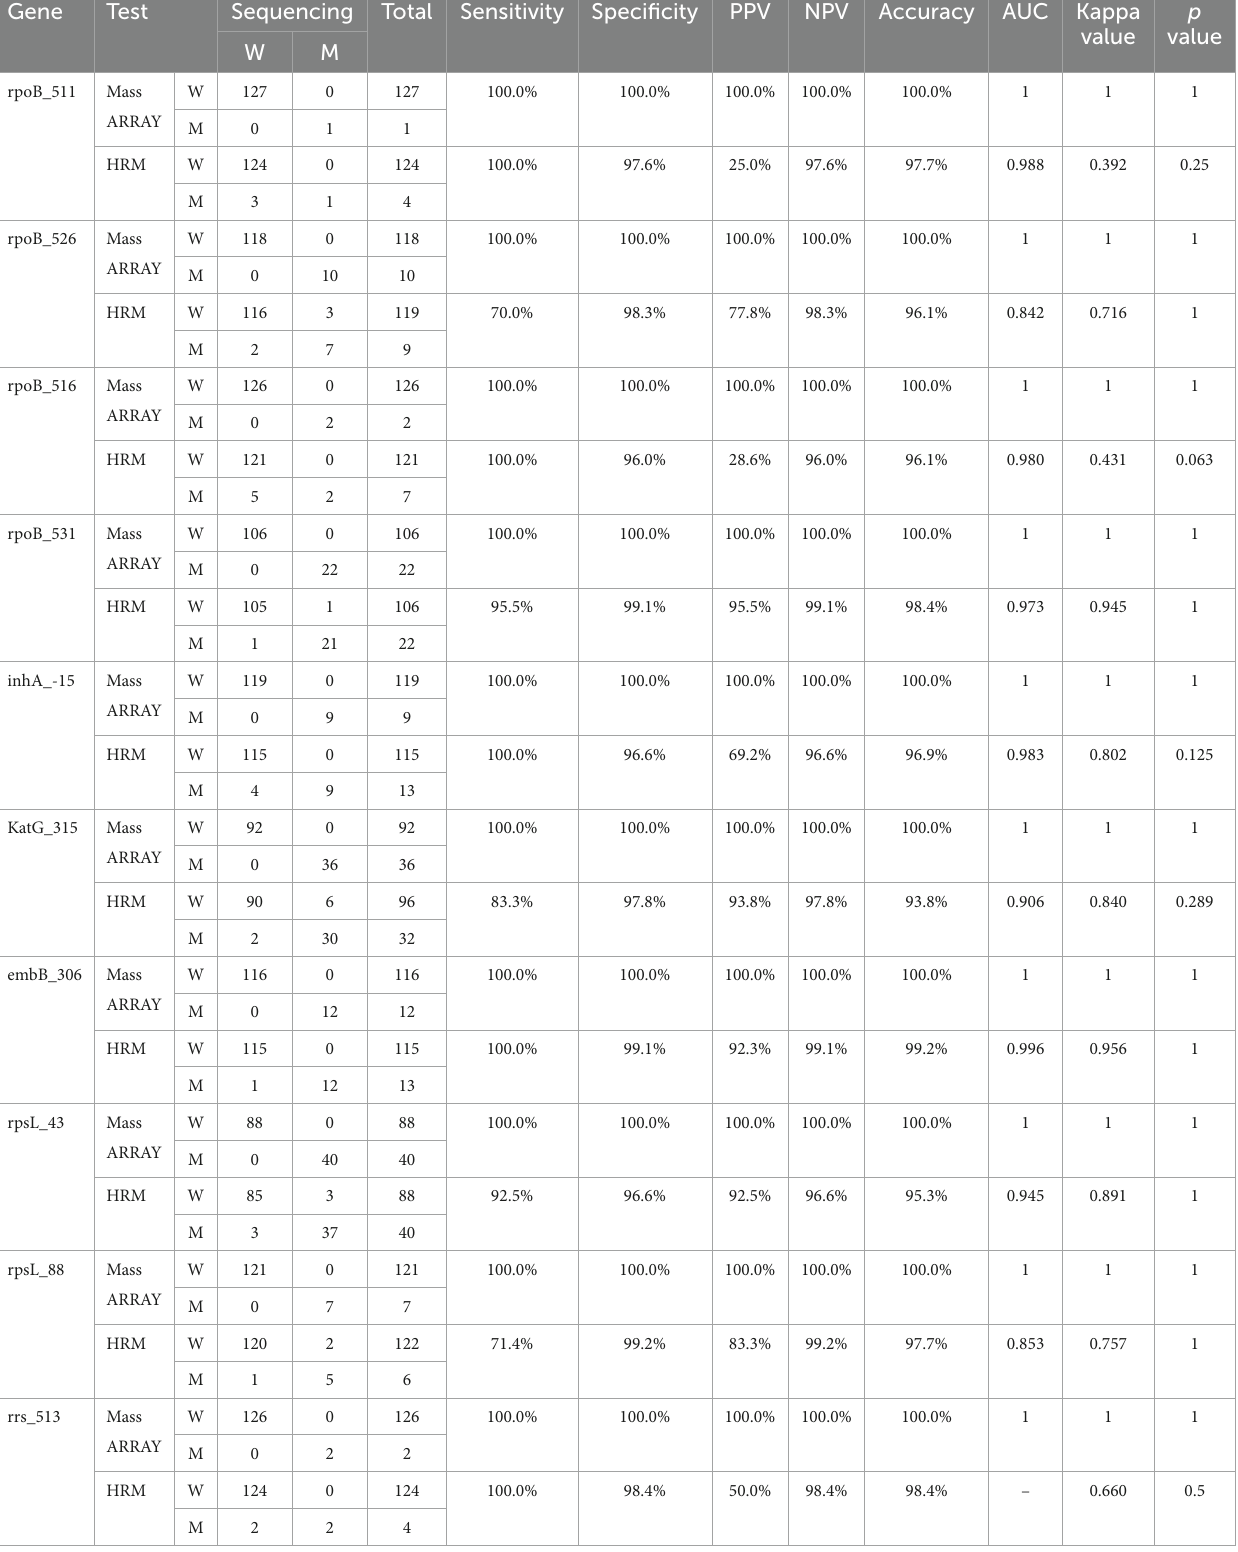
TABLE 4 Analysis of the efficiency of MassARRAY for gene mutation detection.